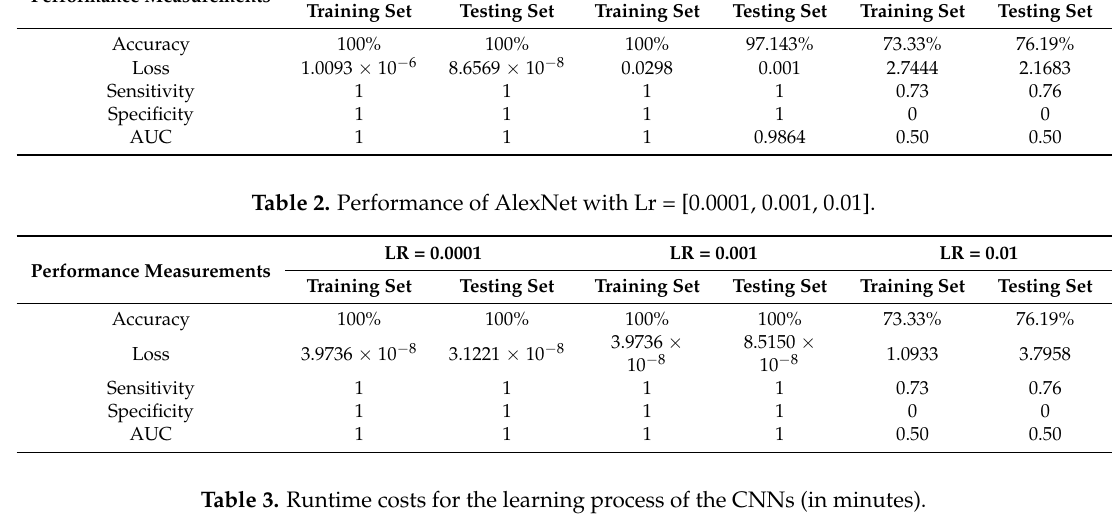
Table 1. Performance of GoogLeNet for training and testing data set with three different learning rates.